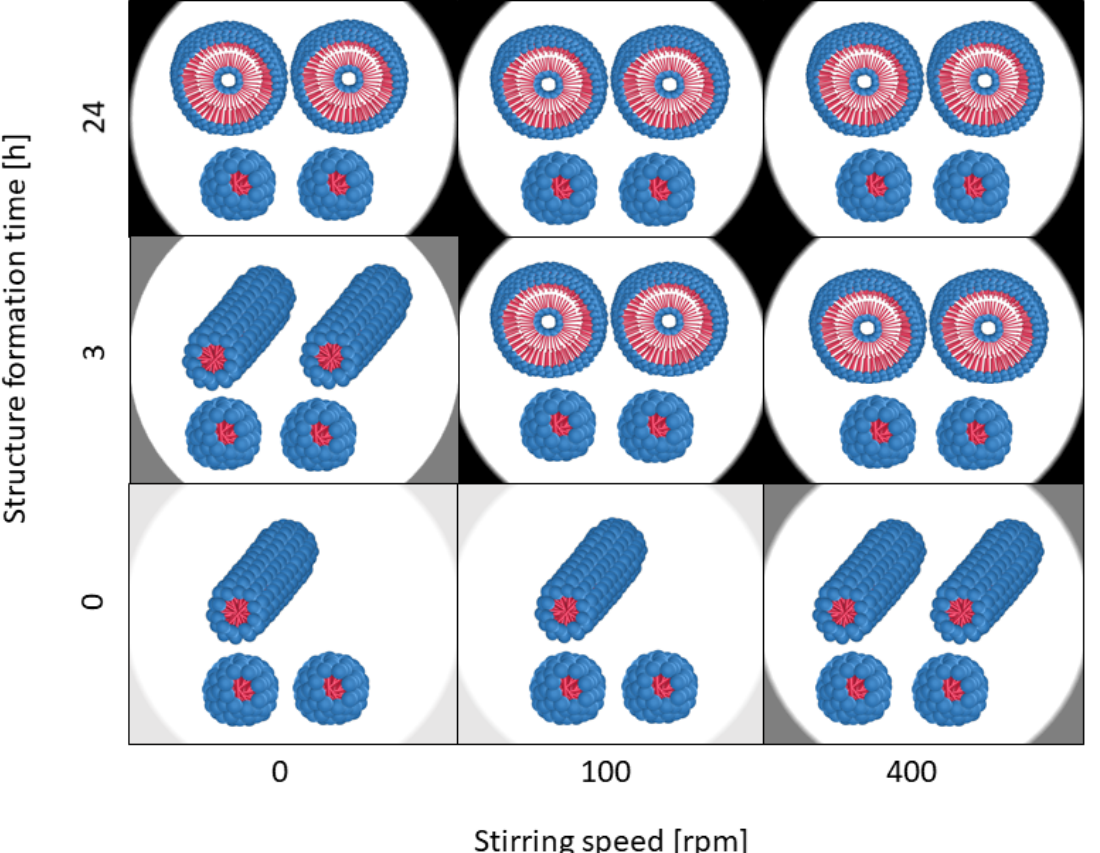
Figure 7. Schematic representation of the morphologies of the polymer structures (blue for the hydrophilic head PAA and red for the hydrophobic part PS), as detected from representative SEM images for each sample, as a function of the structure formation time and the stirring speed. The colored backgrounds distinguish the number and type of morphology (light grey = few cylindrical structures, medium grey = higher number of cylindrical structures and black = vesicles).